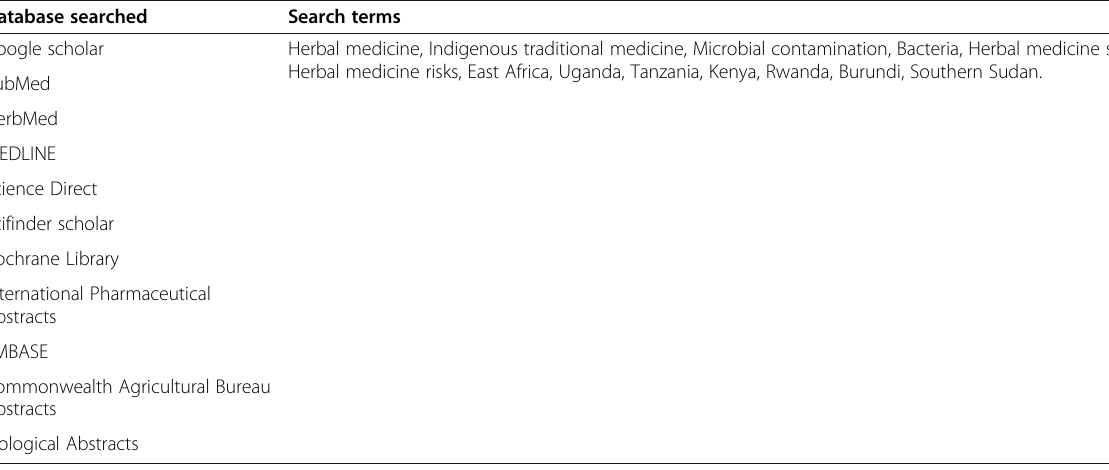
Table 1 Databases searched and the search terms used to identify publications on bacterial contamination of herbal medicines in the EAC member countries since